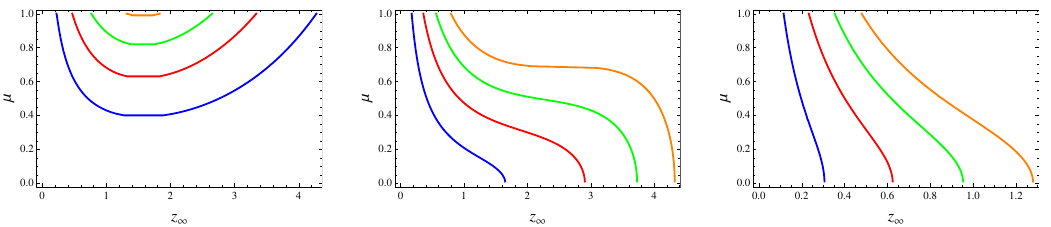
Figure 5 . Chirally symmetric pro(cid:12)les characterized by z 1 for given (cid:22) . Di(cid:11)erent lines correspond to di(cid:11)erent values of the magnetic (cid:12)eld b = 0 : 025 (blue), b = 0 : 05 (red), b = 0 : 075 (green) and b = 0 : 1 (orange). The left, center and right panels correspond to v T = 0, v T = 0 : 1 and v T = 0 : 3 respectively. Note that the apparent perfectly straight sections at the bottom of the curves in the left (cid:12)gure are a numerical artefact.